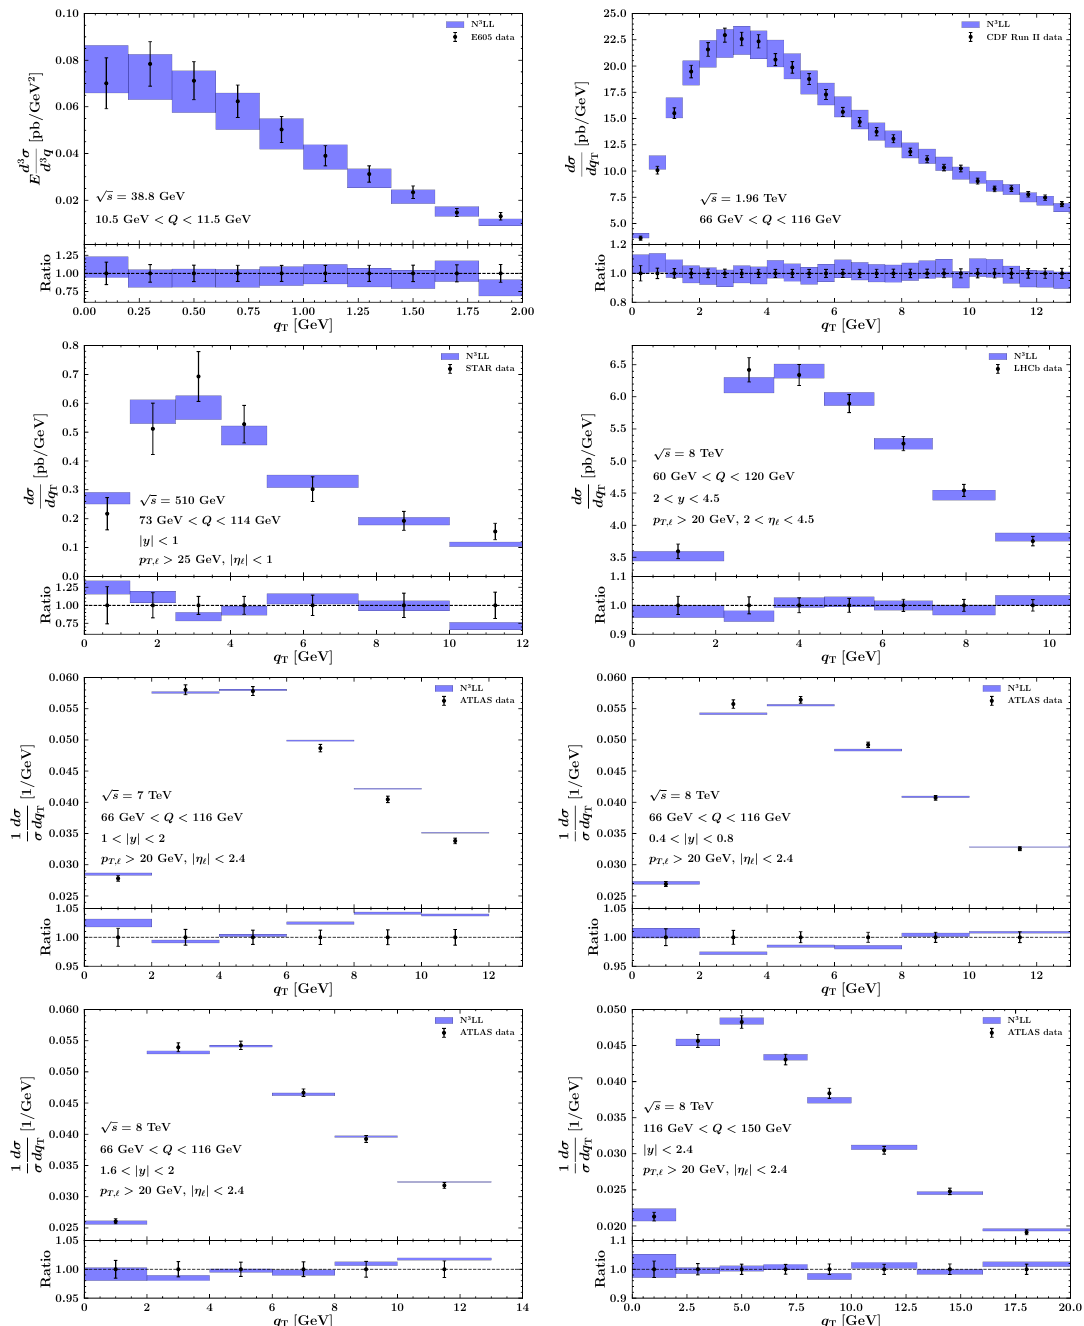
Figure 4 . Comparison between experimental data and theoretical predictions obtained at N 3 LL accuracy for a representative subset of the datasets included in this analysis. The upper panel of each plot displays the absolute q T distributions, while the lower panel displays the same distributions normalised to the experimental central values. The blue bands represent the 1- (cid:27) uncertainty of the theoretical predictions.